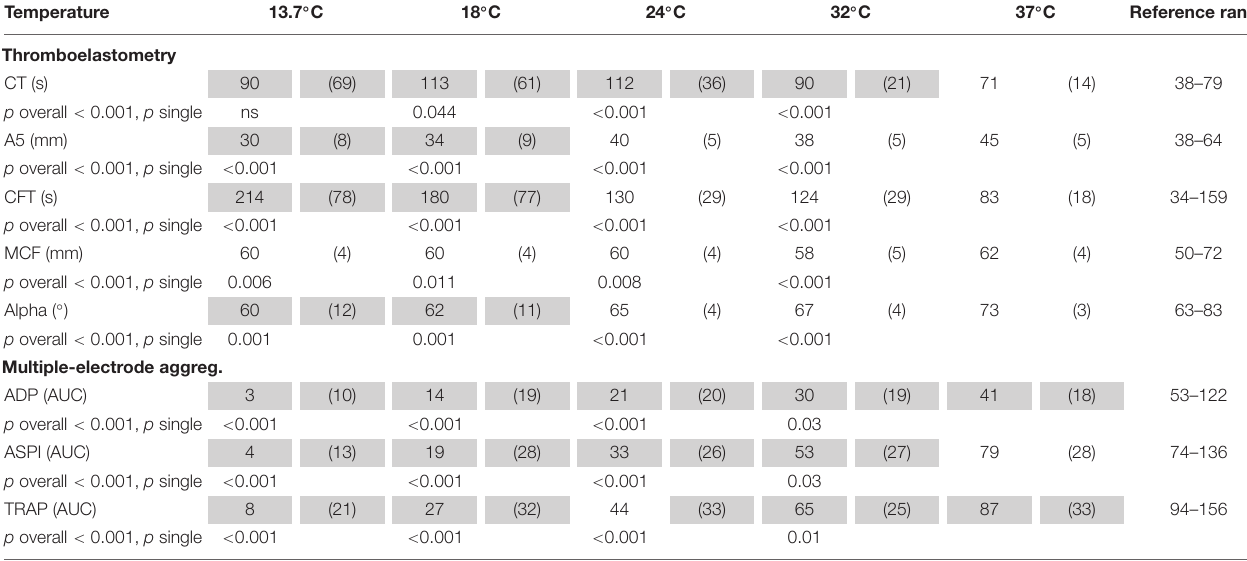
TABLE 2 | Laboratory parameter.